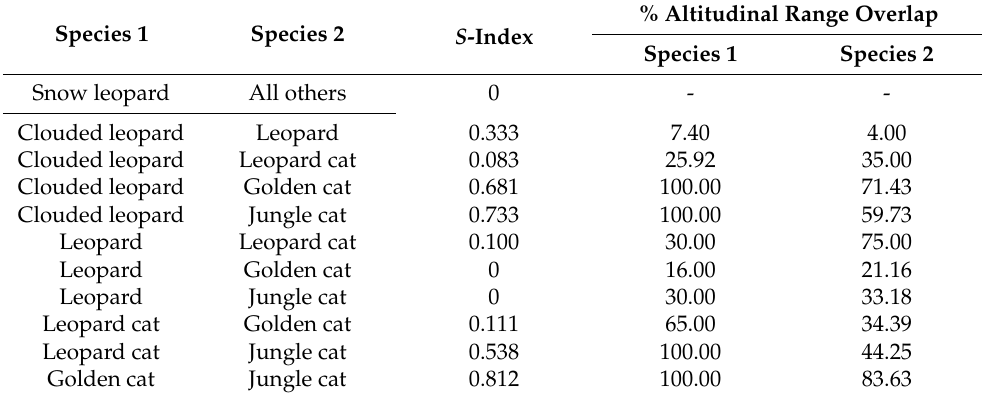
Table 2. Spatial overlap (Jaccard similarity index ‘ S ’) and altitudinal range overlap between pairs of felid